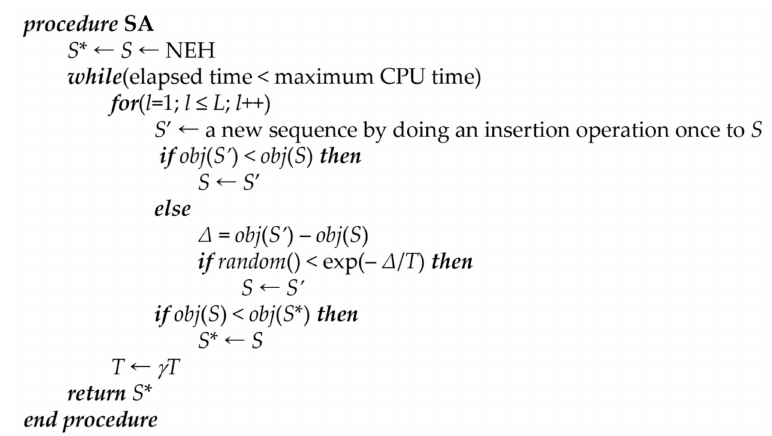
Figure 3. Procedure of the proposed SA